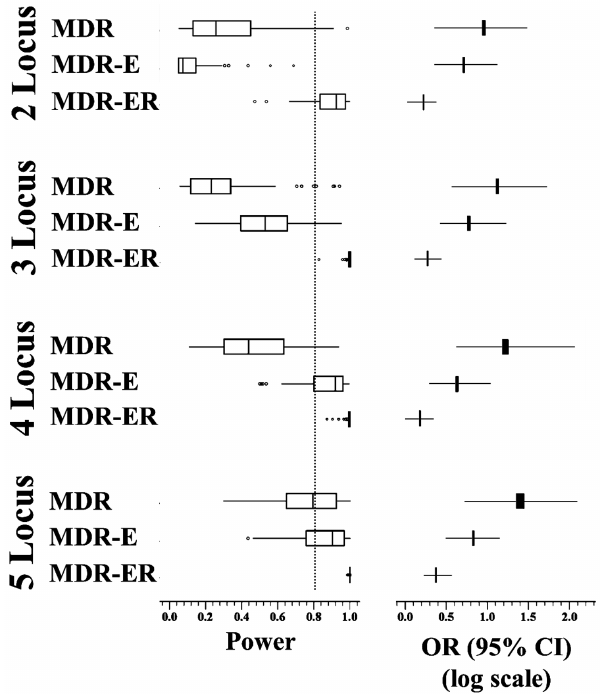
Figure 2. Power analysis of the four methods in 10-fold cross- validation.